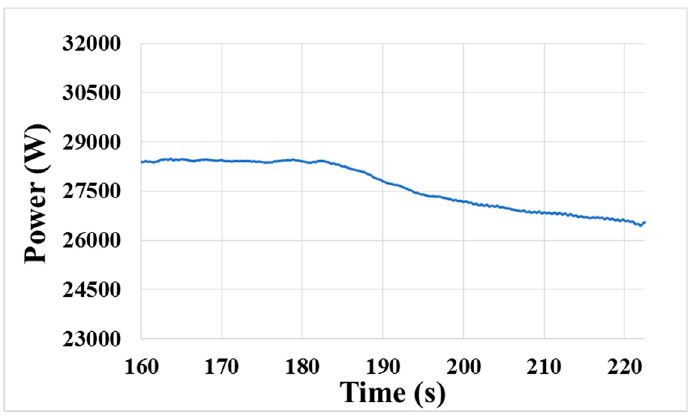
Figure 9. Smoothed signal curve of final experiment during the transition region.